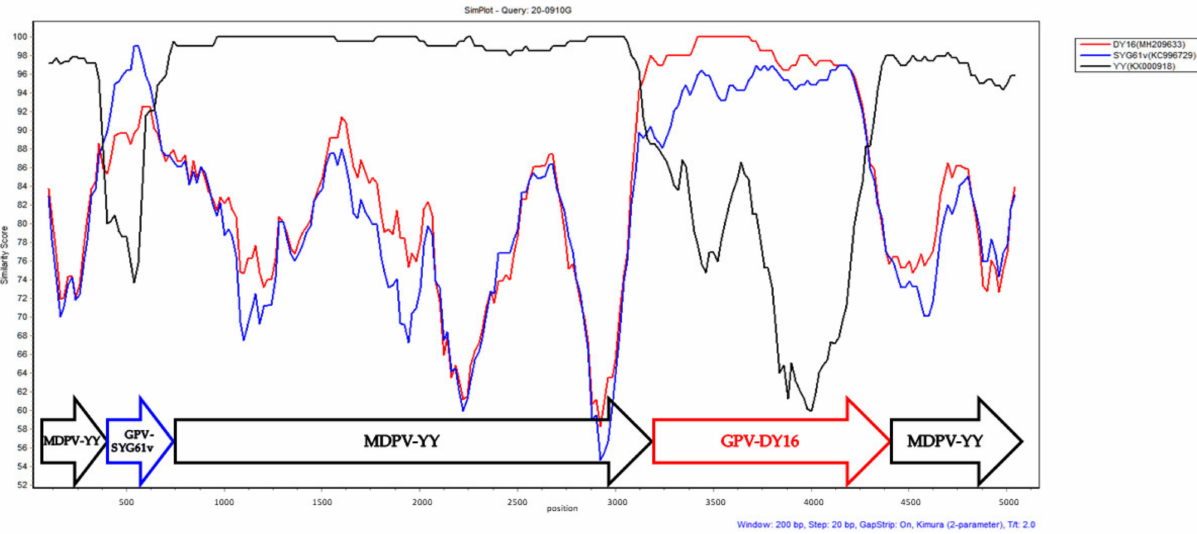
Figure 1. The Simplot analysis of the complete genomic sequences of GPV and MDPV. The 20-0910G isolate was used as the query. The YY, SYG61v, and DY16 strains were the potential parental strains. Two regions, at nucleotide positions 423–615 and 3121–4251, were found to contain the recombination breakpoints. The pairwise distance with a window size of 200 bp and step size of 20 bp were used for the analysis. The potential recombination breakpoints are located at the junction of forward